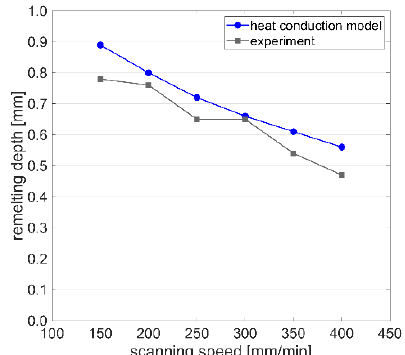
Figure 14. Comparison of the remelting depth computed by the heat conduction model with the experimental results for P = 1000 W and T = 20 °C with scanning speeds varying from 150 to 400 mm/min.